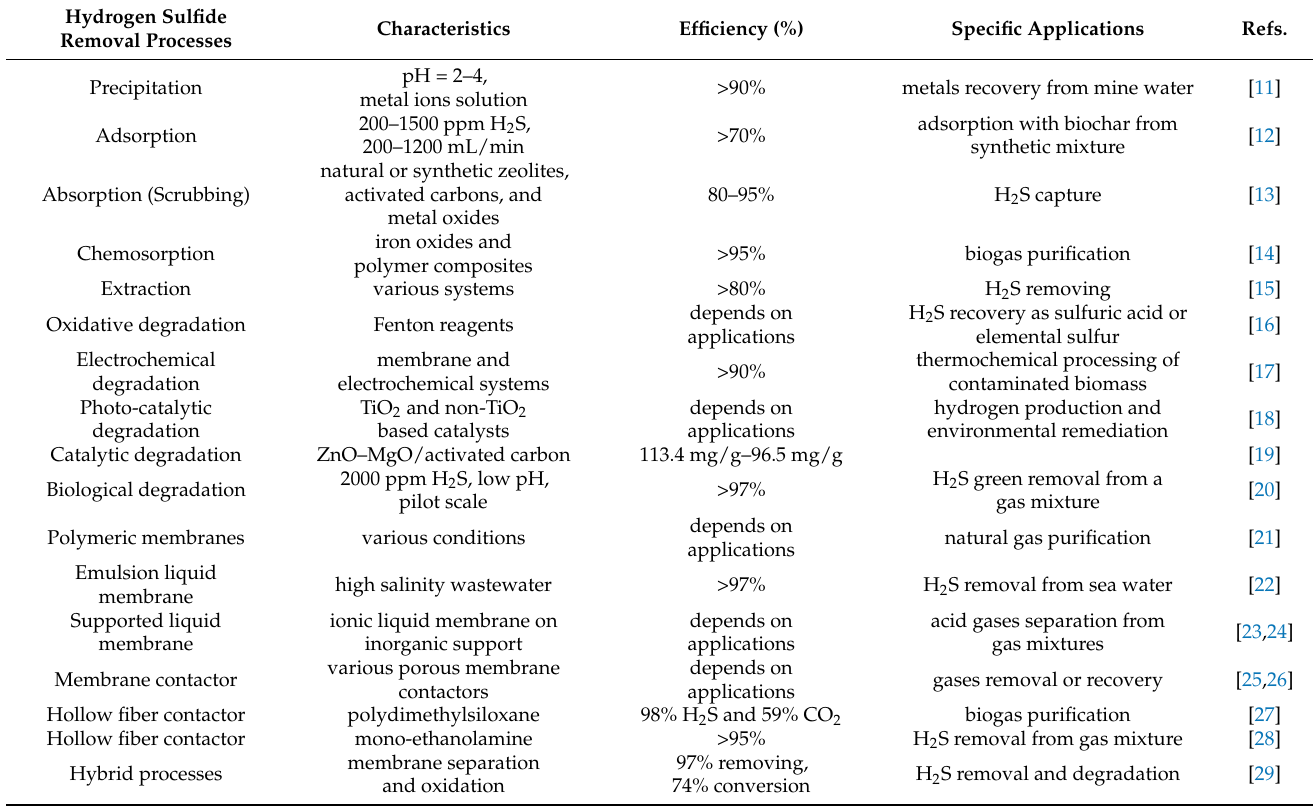
Figure 1. Schematic presentation of the removal, capture, and sequestration of hydrogen sulfide as metal sulfides or oxidation products: oxides, sulfites, sulfates. Table 1. The hydrogen sulfide removal processes and specific characteristics and